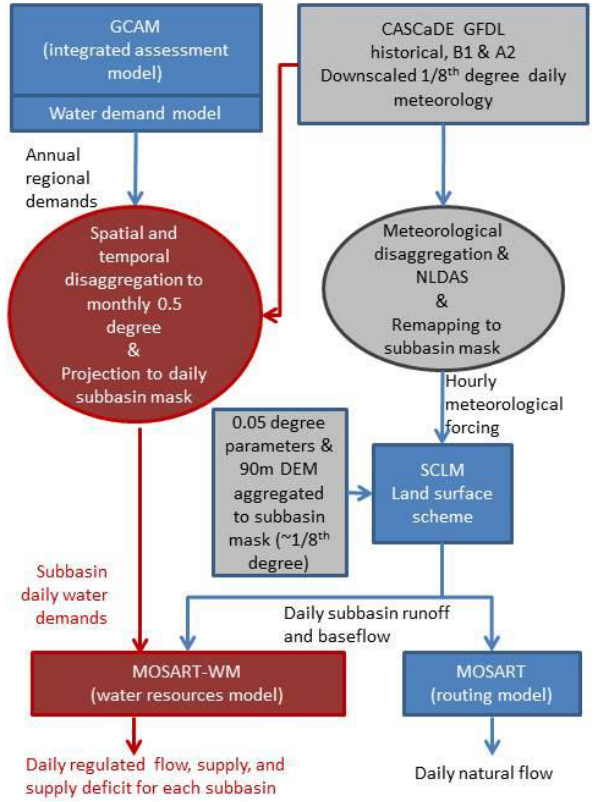
Figure 2: Schematic of the system. The paper describes and evaluates the coupling of the water demand model with the water resources model (red). Publicly available datasets processed for the experiments are in grey. Models are in blue.